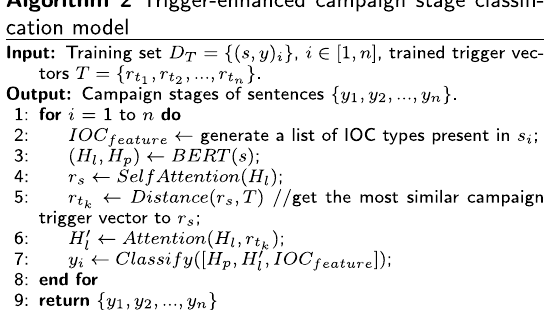
Fig. 6 The demonstration of the trigger-enhanced campaign stages classification model. r t vector r s , which is highly explanatory for the campaign stage. The final input of the model is: the type features of the IOCs IOC feature , weighted hidden representation H ′ l , and H p . Note: the original value of “$URL$” is “http://5. 79. 66. 241/ index.